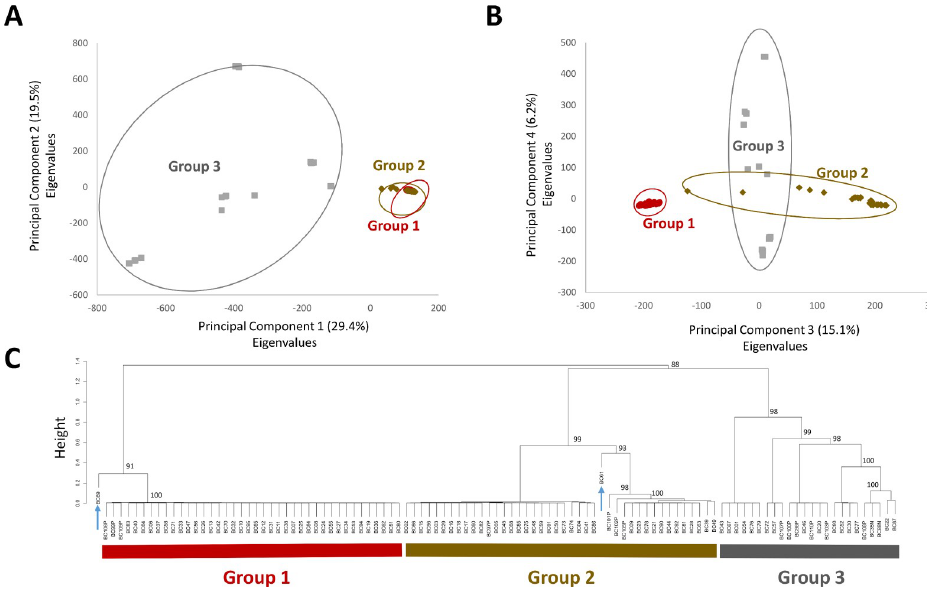
Fig 2. Analysis of principal components for nucleotide variants identified by whole genome alignments. Variants were identified based on whole genome alignments using MUMmer. Sample relationships based on the eigenvalues from the first two principal components (A), and the third and fourth principal components (B) are shown (S8 Table). Percentage of variance explained by each component is indicated in brackets. C, Dendogram of the variant-based principal component analysis using ‘prcomp’ and clustering by ‘pvclust’, bootstrapping values indicate the approximated unbiased percent likelihood based on 1,000 clustering iterations. Blue arrows indicated samples BC61 and BC69, which occupy unique branches. The colour of the groups, and samples within, are the same as in Figs 1 and 3.